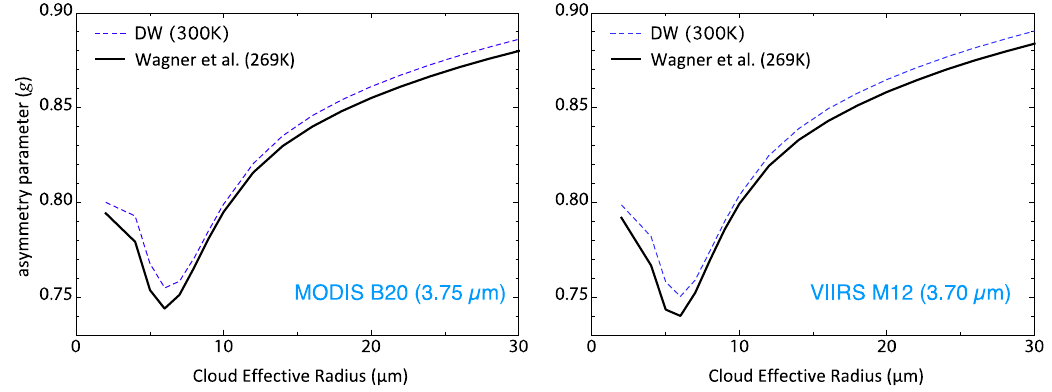
Figure 4. Same as Figure 3 but for the MWIR channel droplet asymmetry parameter.